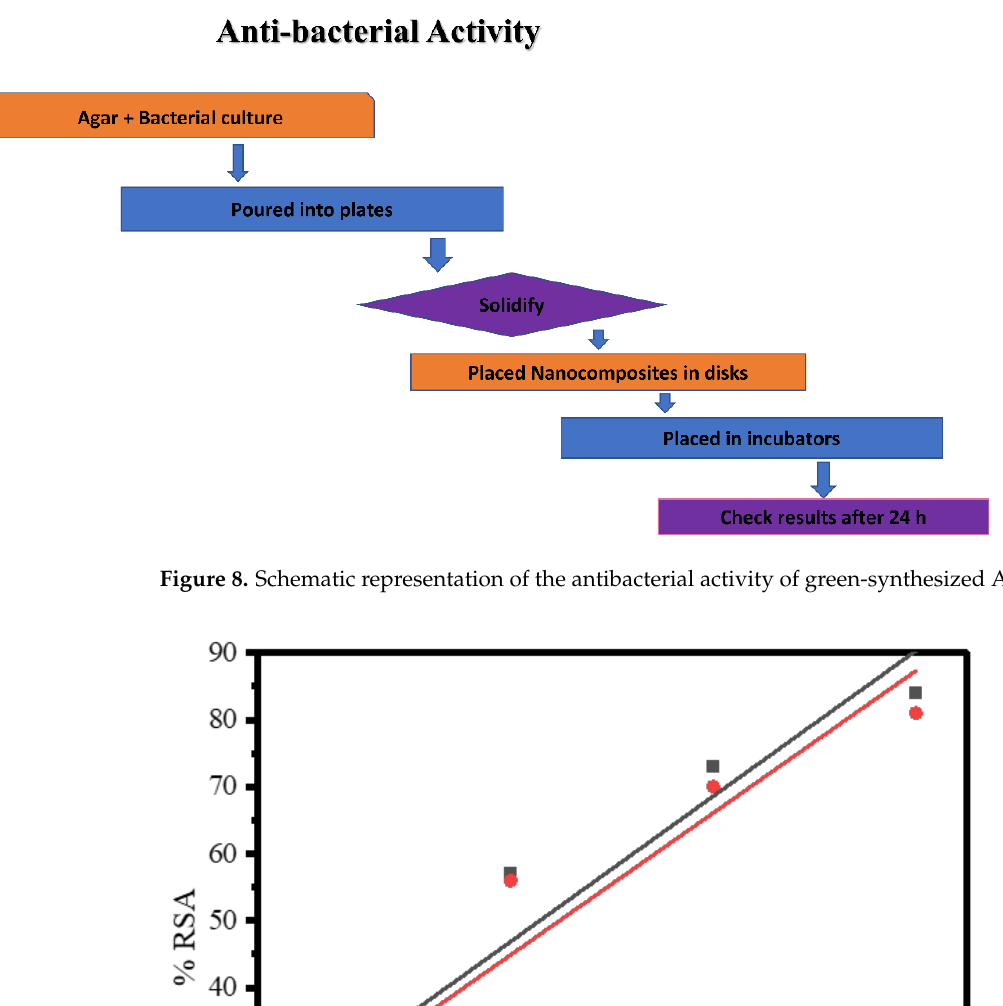
Figure 7 Antibacterial activity of biosynthesized ( a ) Non-calcined Ag NPs against S. aures, ( b ) Cal- cined Ag NPs against S. aures.